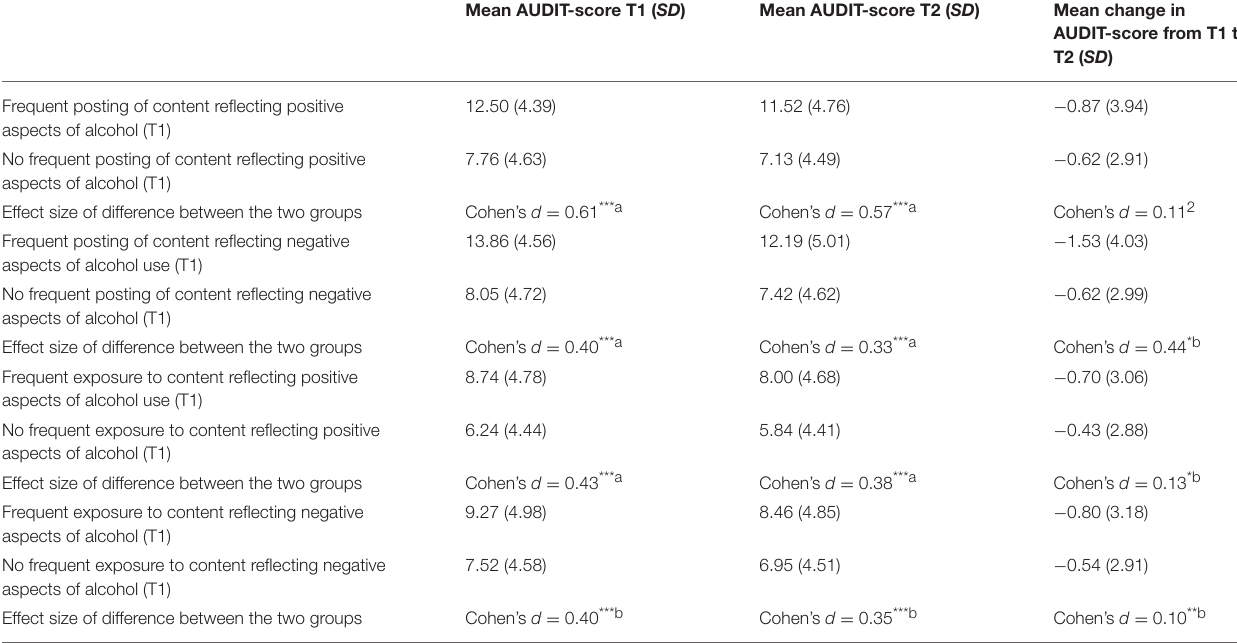
TABLE 2 | Mean AUDIT-scores among the frequent disclosure and exposure groups.